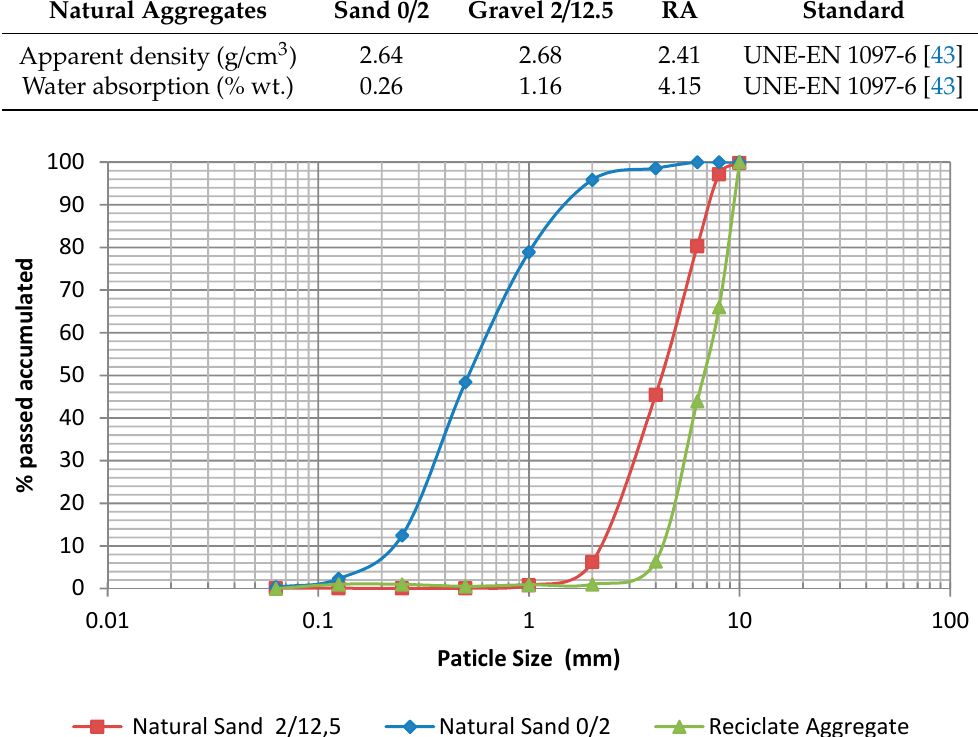
Table 4. Results of fresh concrete consistency.